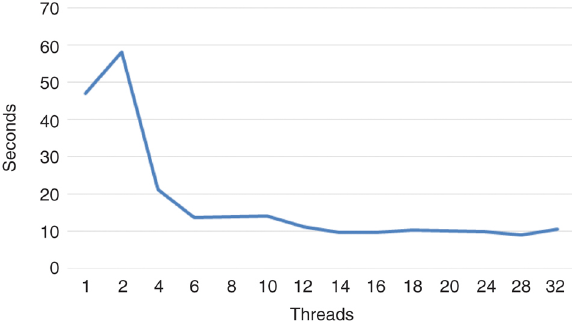
Figure 8: Total time with respect to the number of threads.